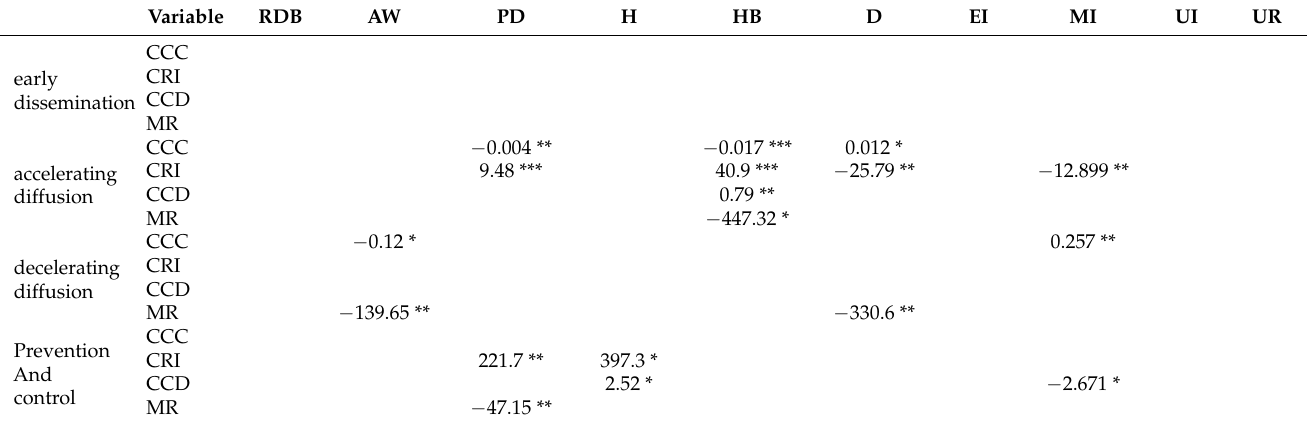
Table 3. The interaction of COVID-19 and socioeconomic variables on environmental risk